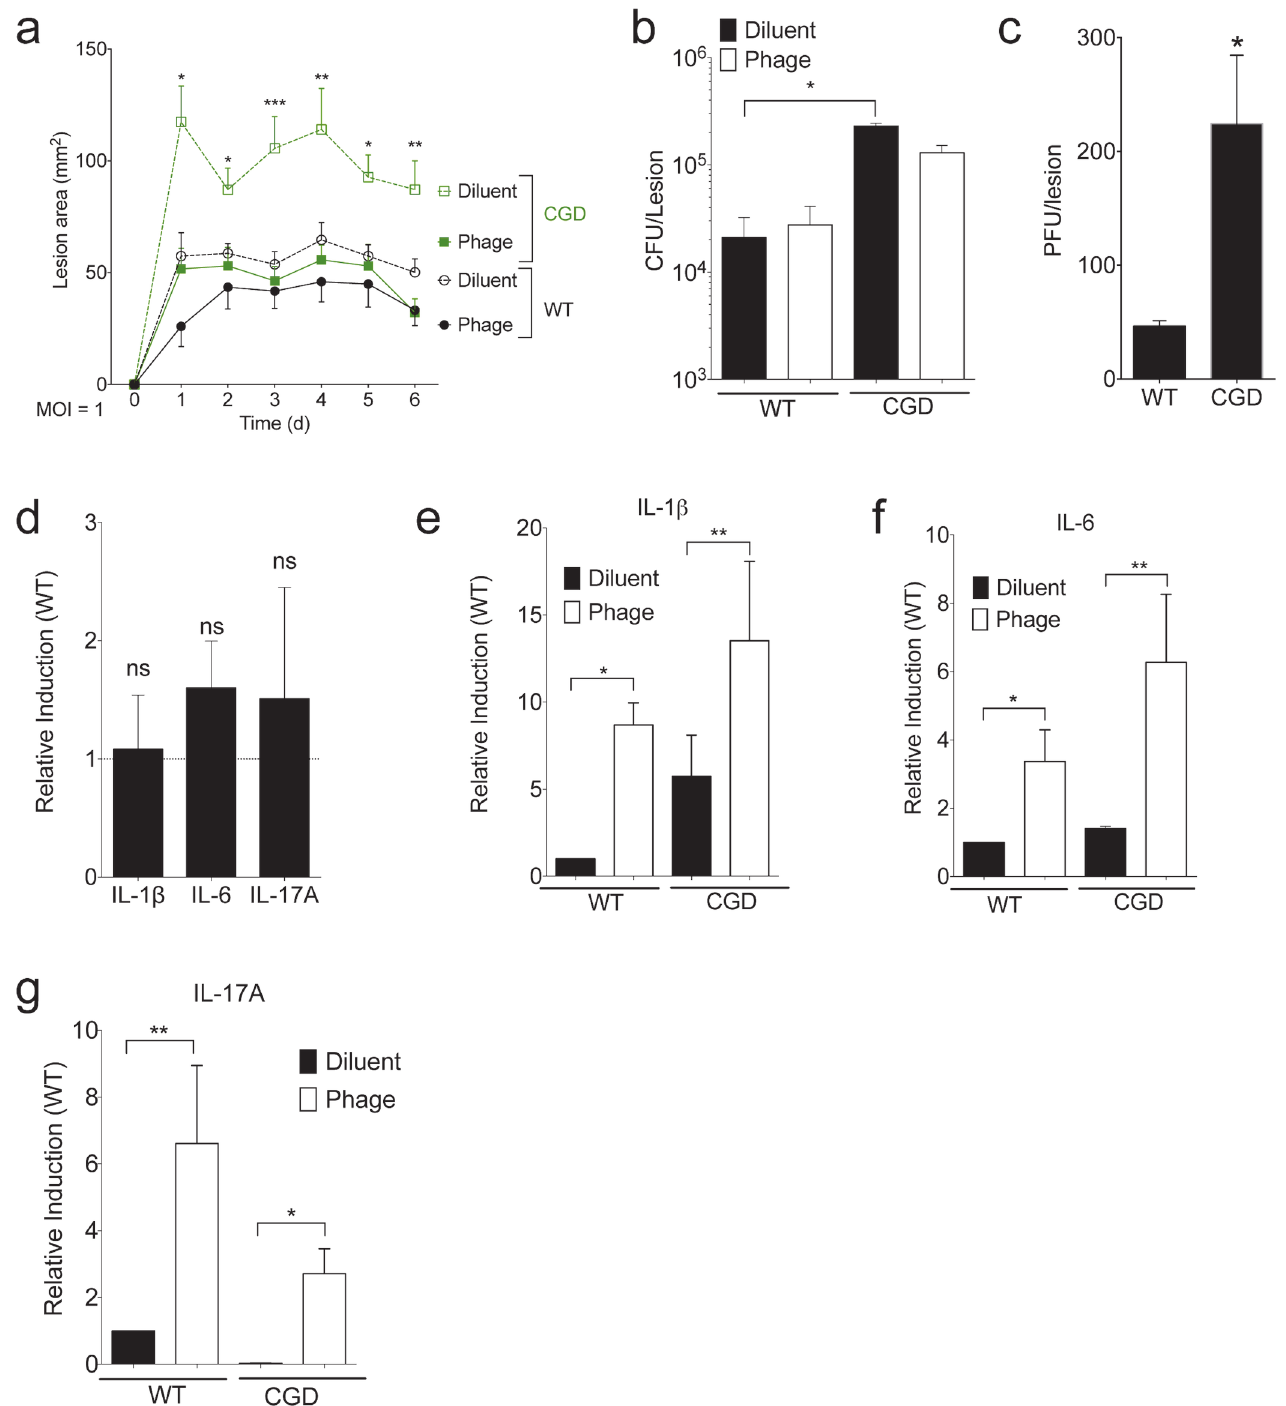
Fig 2. SATA-8505 Improves MRSA Skin Infection at Low MOI. Mice were injected intraperitoneally (I.P.) with 10 7 plaque-forming units (PFU) of SATA- 8505 immediately prior to subcutaneous injections of 10 7 CFU of USA300. (a) Lesion size progression over following six days. On day 6, skin biopsies were homogenized for culture, total bacterial (b) and phage burden (c) were calculated for individual mice. (d) mRNA transcript levels for IL-1ß, IL-6, and IL-17A in individual CGD mice relative to wild type controls, standardized to GAPDH. (e-g) mRNA transcript levels for IL-1ß, IL-6, and IL-17A in CGD and wild type mice with and without SATA-8505 treatment relative to wild type controls injected with diluent, standardized to GAPDH. Data shown are representative of 2 – 3 independent experiments using 5 or more mice per group, and displayed as mean + s.e.m. Differences were calculated by ANOVA with Bonferroni correction and depict differences from diluent treated wild type unless otherwise noted. ns = not significant, * = p < 0.05, ** = p < 0.01.